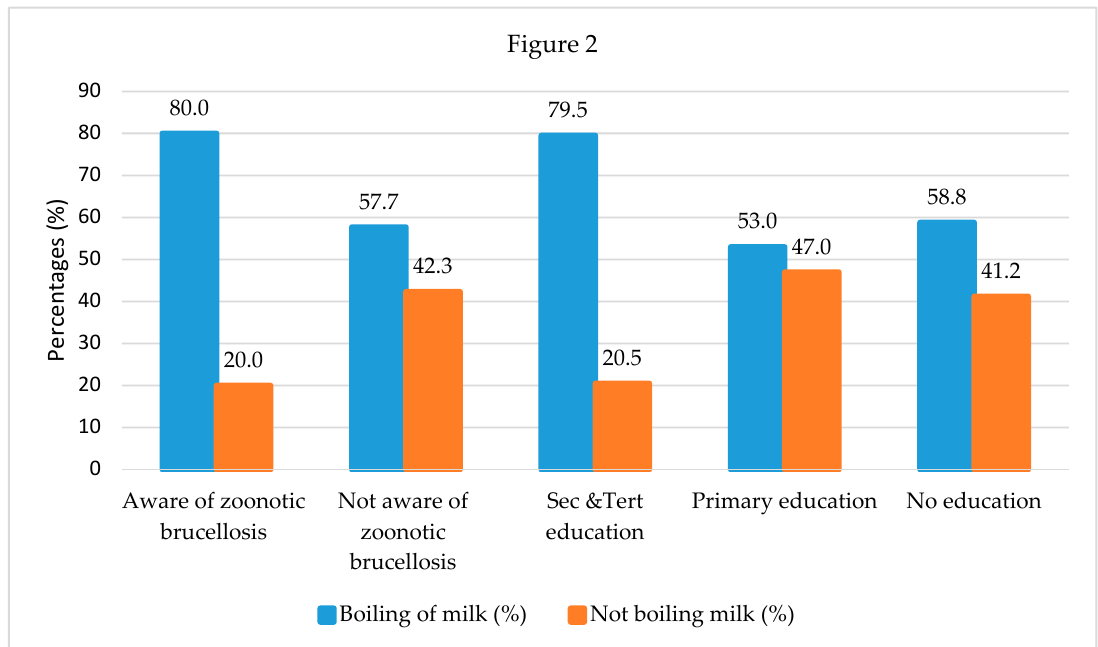
Figure 2. Pairwise correlation between awareness of zoonotic brucellosis, education level, and drinking raw milk in cattle keepers in Rwanda.